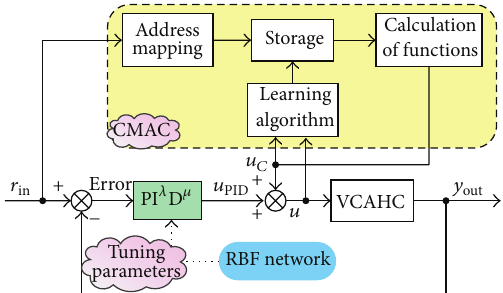
Figure 5: Structure and principle of the compound control based on CMAC and PI 𝜆 D 𝜇